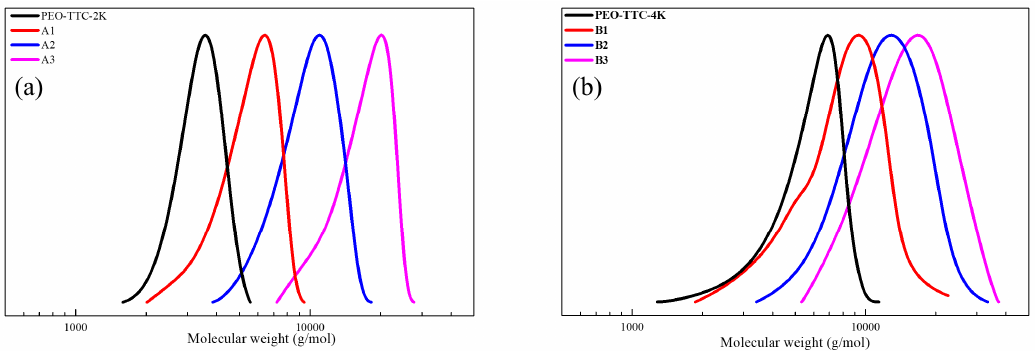
Figure 5. GPC trace of ( a ) PEG2k-b-PDVBP, ( b ) PEG4k-b-PDVBP.